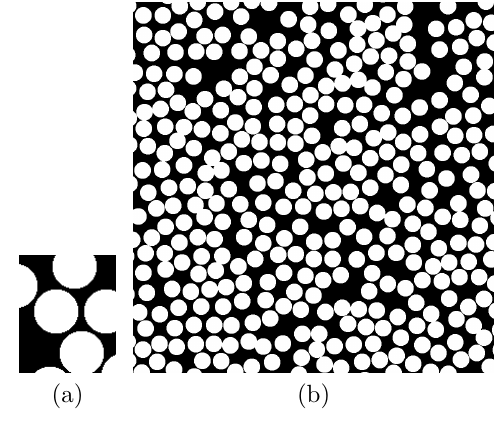
Figure 4. a) Carbon cell with the lowest volume, b) Carbon cell with the highest